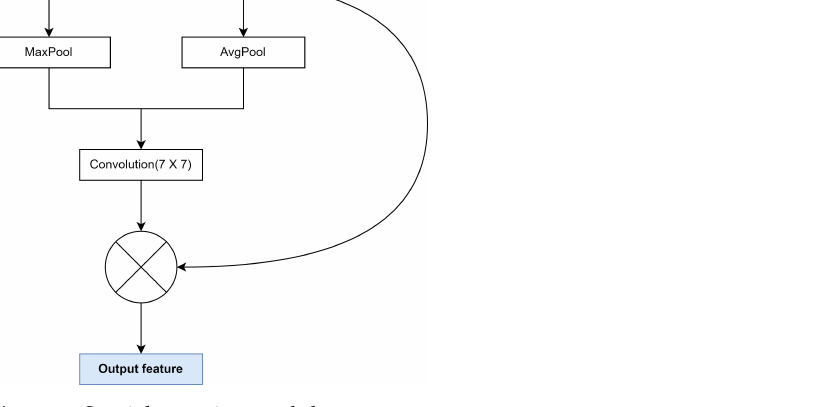
Figure 3. Spatial attention module.